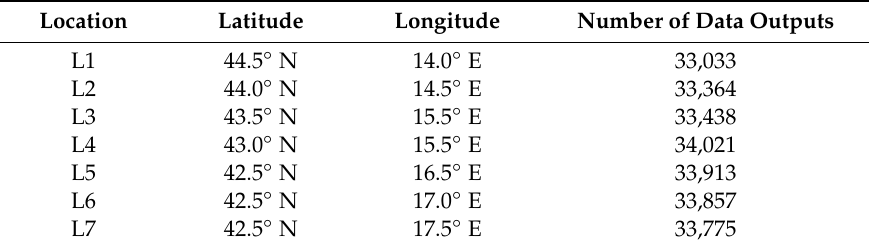
Table 1. Selected locations in the Adriatic Sea.